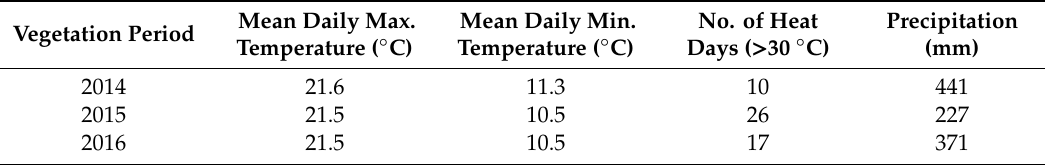
Vegetation Period